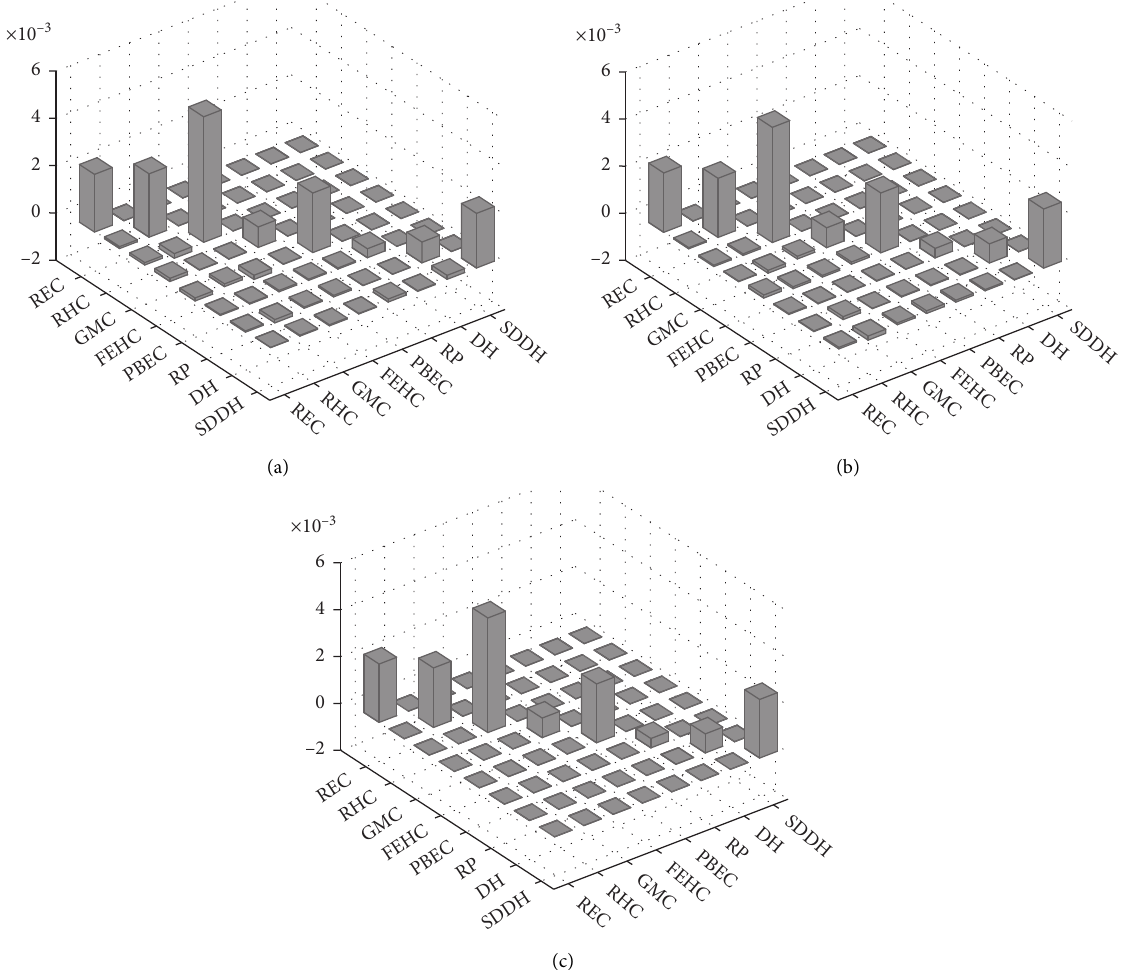
Figure 6: The relative covariance matrix generated by CUSA with the sample size of 500. (a) Generated by SRS. (b) Generated by LHS. (c) Generated by